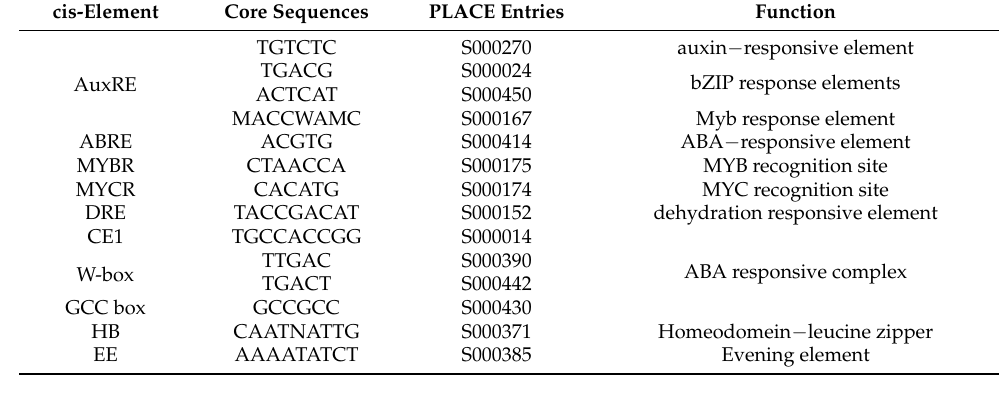
Table A10. PLACE entries of cis − elements within the promoters of auxin transporter genes.